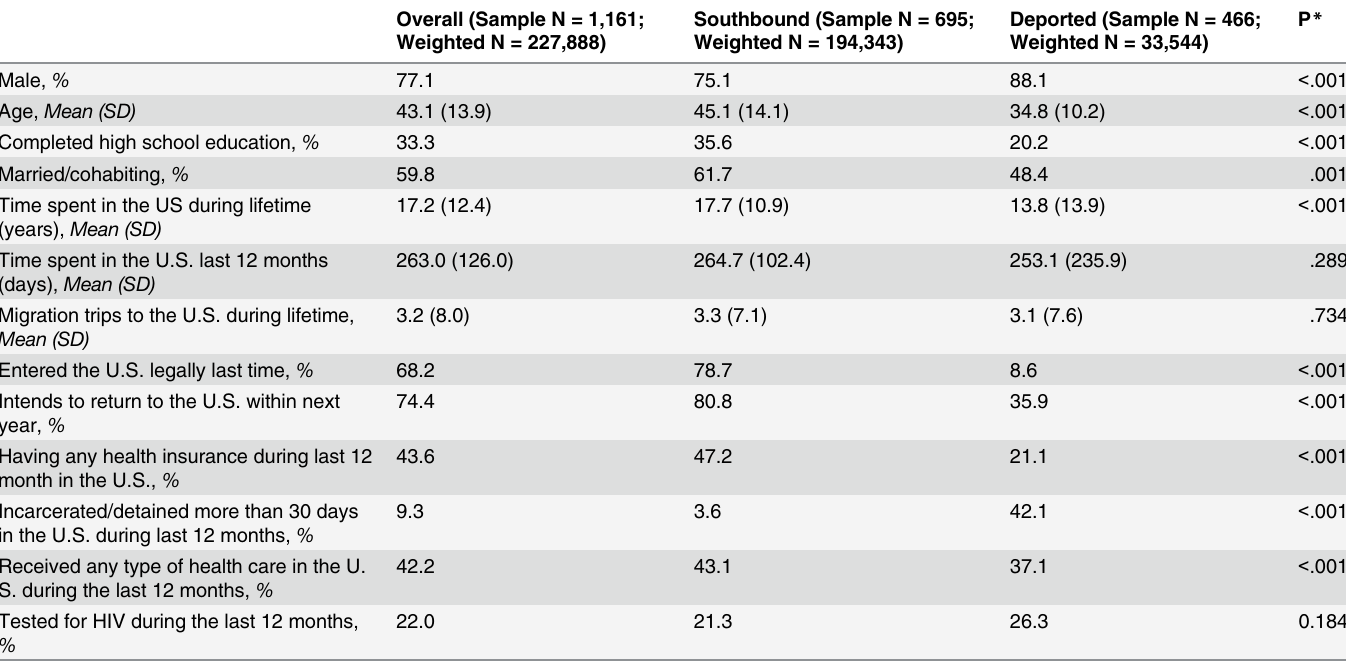
Table 1. Socio-demographic, migration characteristics of Mexican migrants returning from the U.S. via Tijuana, Mexico. Overall (Sample N = 1,161; Weighted N =